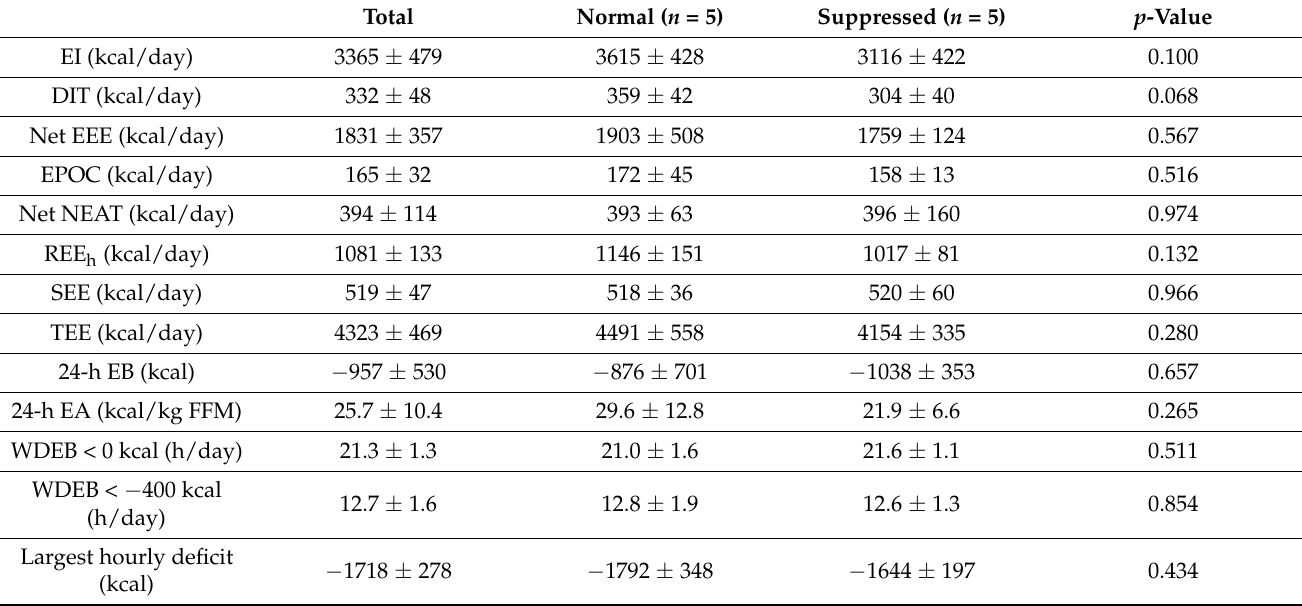
Table 3. EI, EE components, and WDED variables of the participants during training days.